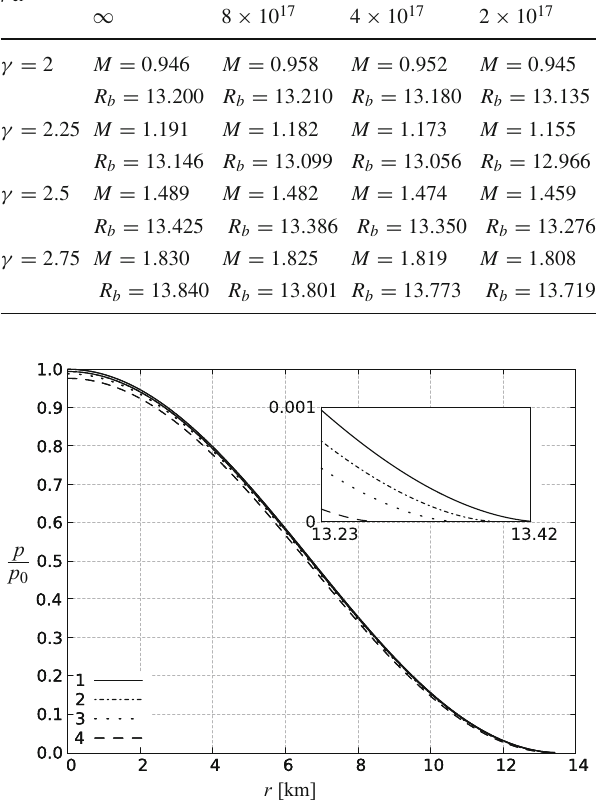
Fig. 4 Pressure profile for compact objects with ECT-inspired cor- rections and polytropic equation of state with k = 7 . 454 × 10 − 3 , γ = 2 . 5. All models have the same classical central density ρ 6 . 5 × 10 14 g / cm 3 . See Table 2 for